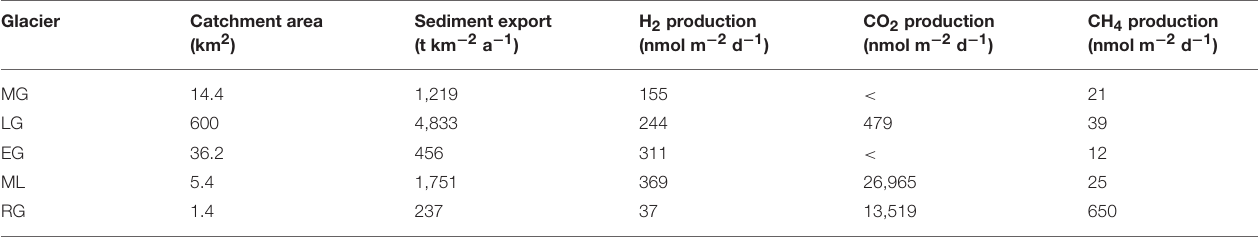
TABLE 5 | Comparison of estimated long-term catchment production rates of H 2 , CO 2, and CH 4 (nmol gas m − 2 day − 1 ) by subglacial grinding.